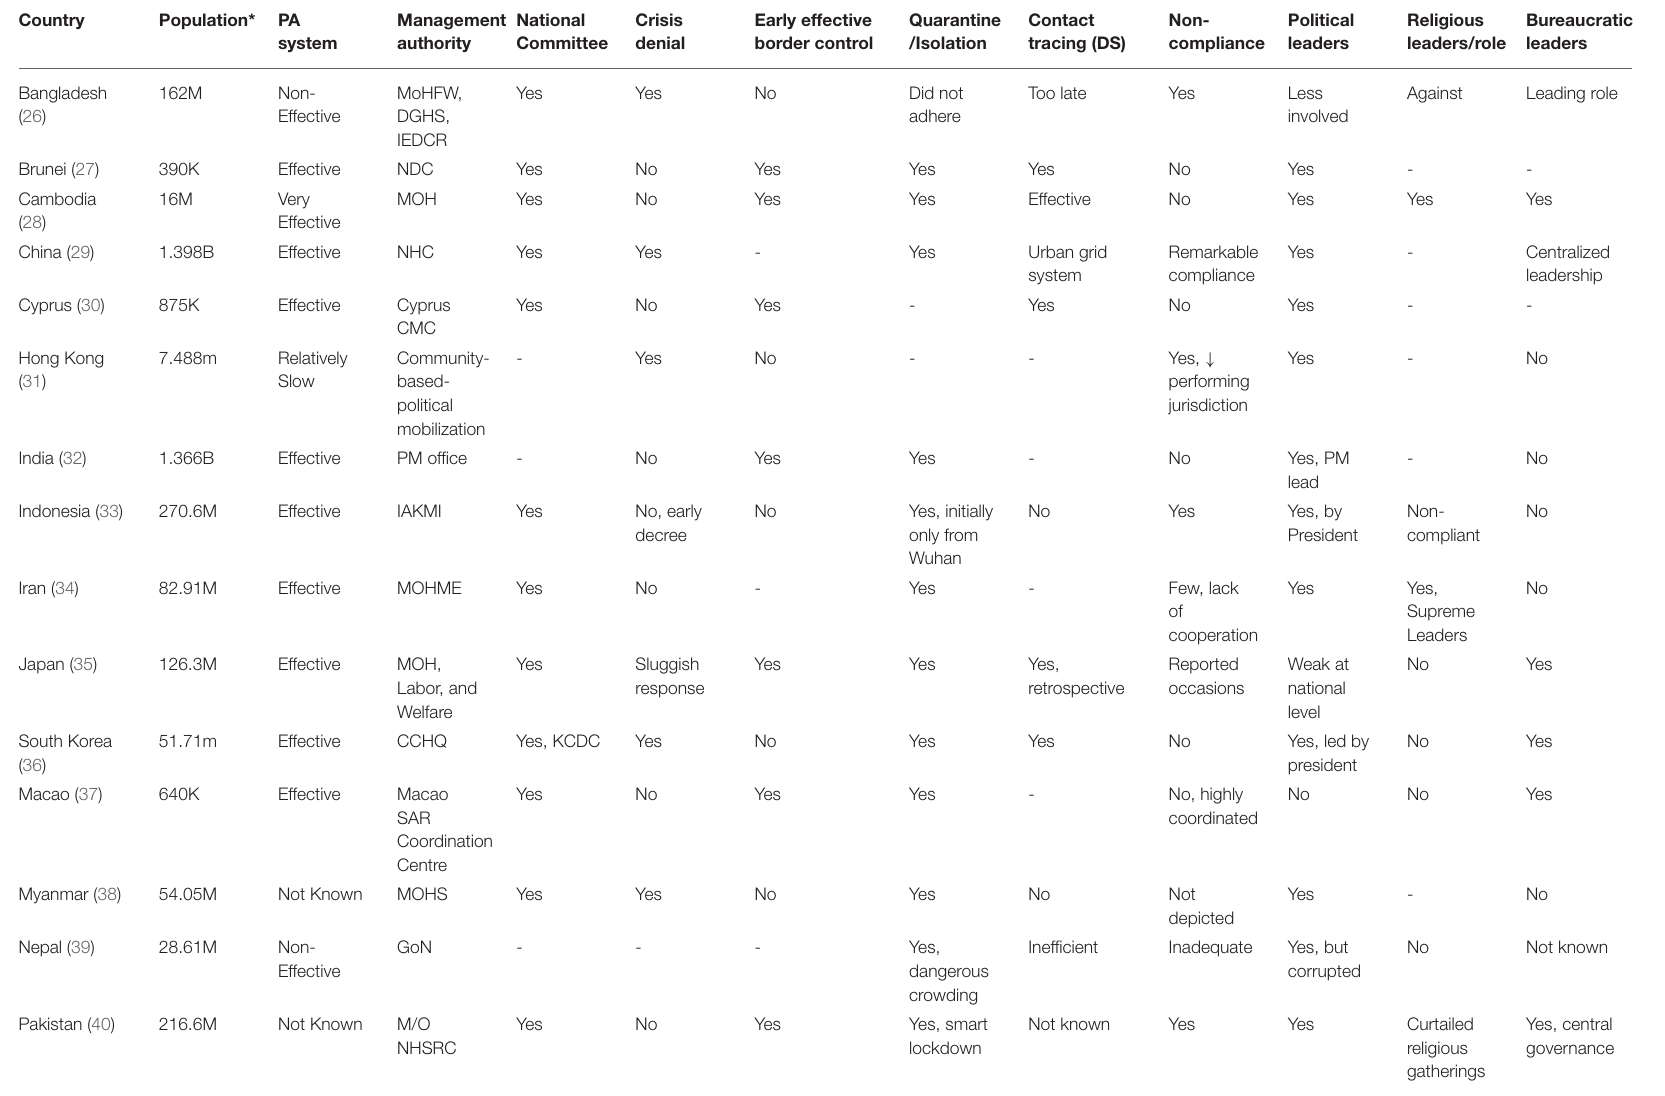
TABLE 3 | Asian countries’ responses in COVID-19 management reflecting the role of leadership.